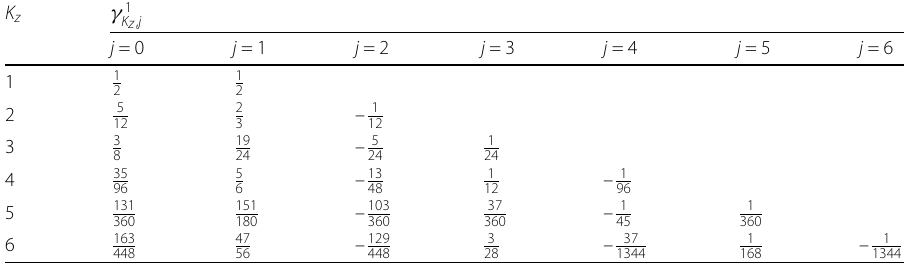
Table 2 The coefficients { γ 1